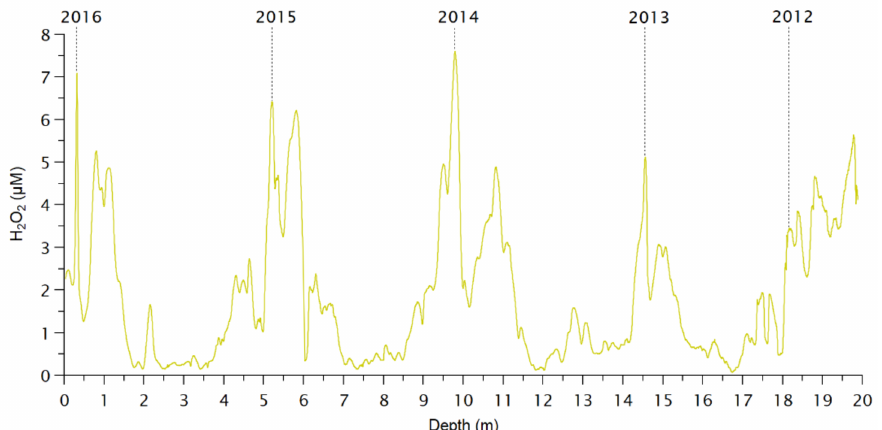
Figure 2. Age-scale construction of firn core OH-12 by counting annual layers in the CFA-derived, high-resolution H 2 O 2 profile. Details are explained in the text.